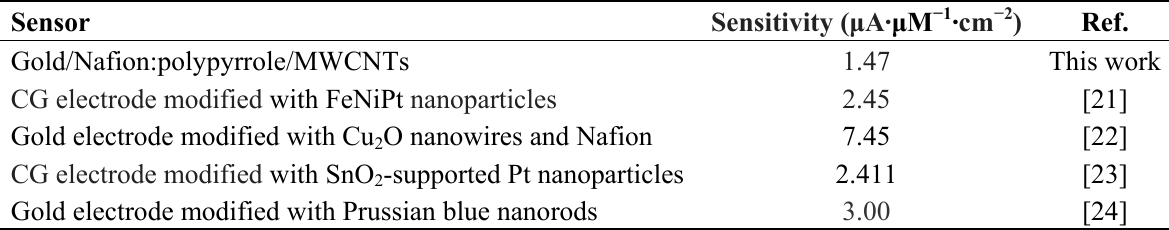
Table 1. Sensitivity of our sensor compared to that of other electrochemical sensors.